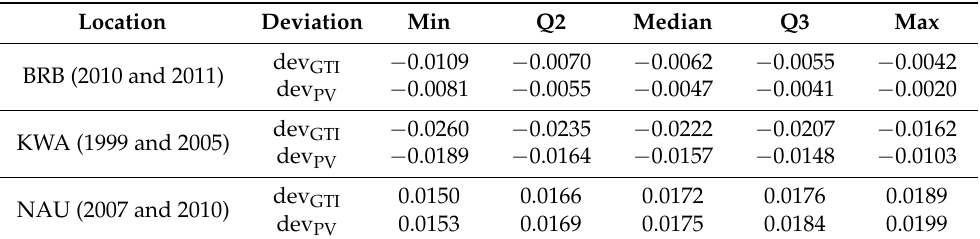
Table 4. Inter-annual variability of the results for fixed-tilt systems for the locations of Brasilia, Brazil (BRB), Kwajalein (KWA) and Nauru Island